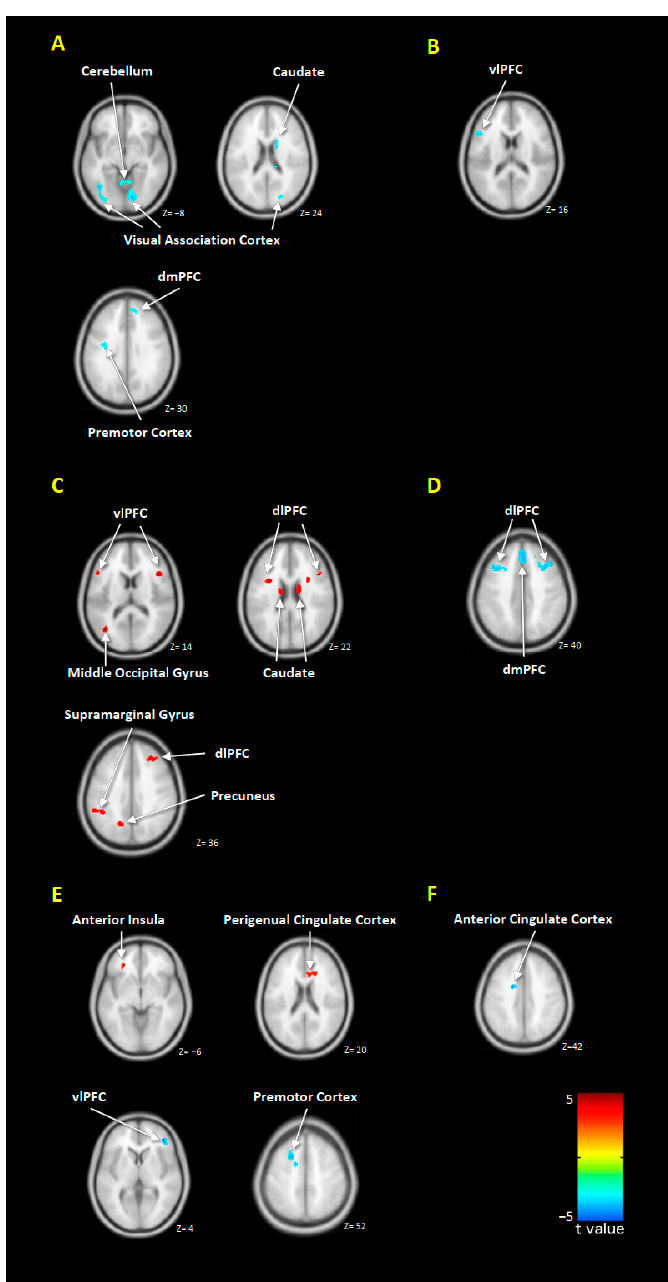
Figure 1. The changes in brain emotional processing in MDD patients. Compared to healthy controls, the untreated MDD patients revealed significant decreased brain responses when processing positive emotion ( A ) and negative emotion ( B ). After treatment, increased brain responses when processing positive emotion has been revealed in EPA group ( C ), while decreased brain responses when processing positive emotion has been revealed in DHA group ( D ). The changes in brain responses were correlated with the changes of HAM-D scores in the EPA ( E ) and DHA ( F ) group. The warm / cold color denotes increased / decreased activity ( A – D ) and positive / negative correlation ( E , F ), respectively. Abbreviation: dmPFC, dorsomedial prefrontal cortex; dlPFC, dorsolateral prefrontal cortex; vlPFC, ventrolateral prefrontal